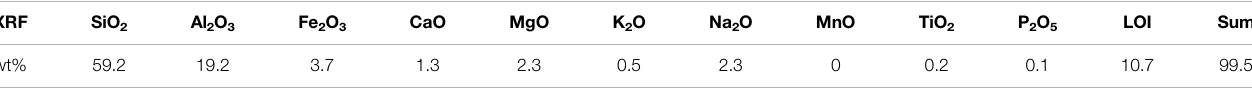
TABLE1| Mineralogicalcompositionofthebentoniteusedinthisstudy.Themassfractionsweredetermined byX-ray fl uorescenceanalysis(Dohrmann,2020)followingthe procedure by Dohrmann et al. (2009). XRF